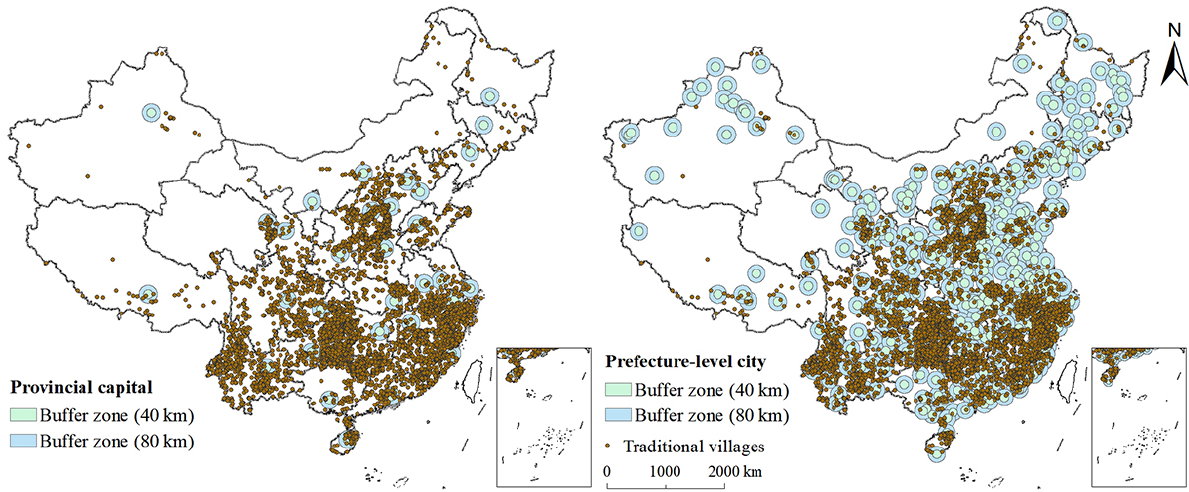
Figure 7. Spatial relationships between the distribution of traditional villages and cities.